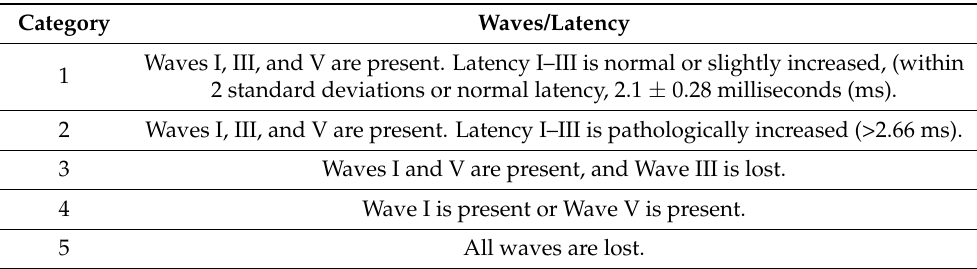
Table 1. Hannover Classification System of Auditory Evoked Potentials